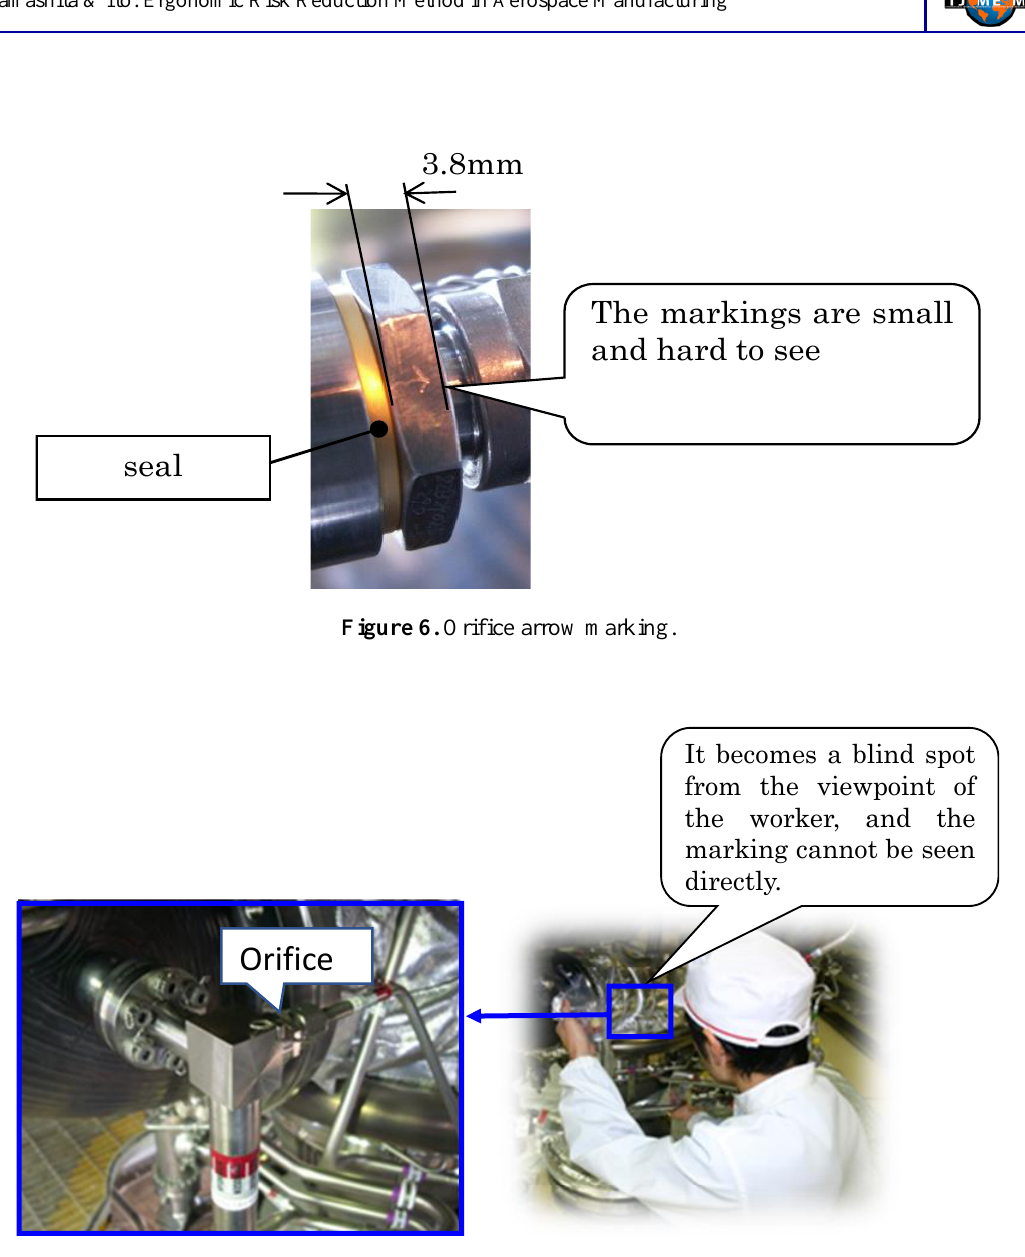
Figure 7. Orifice mounting work